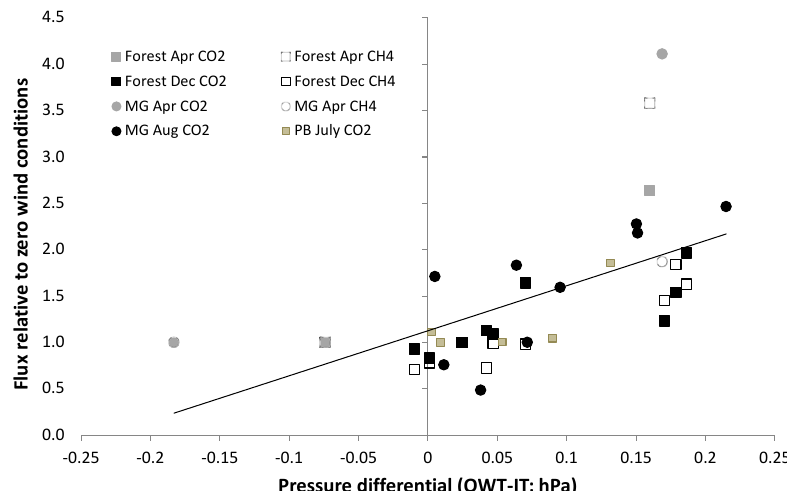
Figure 4. The relationship between measured pressure differential (outer wind tunnel minus inner toroid, in hPa) and flux relative to zero- wind conditions ( F R ). For direct comparison, only data included in Fig. 3 have been included in this figure. Solid fill symbols indicate CO 2 flux ratios while open symbols show CH 4 flux ratios (Tables 2 and 3). Trend line indicates best fit for data ( r 2 = 0 . 37, FR = 4 . 85 × pressure differential (hPa) + 1.13). Table 2. Average CO 2 fluxes (in µmoles CO 2 m − 2 s − 1 ) ± standard deviation for each component of the inner toroid–outer wind tunnel matrix. Italicized top values are for data collected in April 2011 (grassland and forest) and September 2011 (peat bog) while non-italicized bottom values indicate data collected in December and August 2011 and September 2012 for forest, grassland, and peat bog respectively. By convention positive values indicate efflux of CO 2 from the soil surface into the